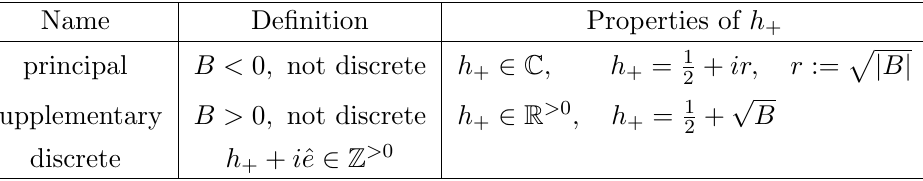
Table 2 . We categorize charged scalar (cid:12)elds in AdS 2 as principal, supplementary, or discrete depending on the values of the mass ^ (cid:22) and charge ^ e . We have de(cid:12)ned h + := 1 = 2 + B := 1 = 4 + ^ (cid:22) 2 (cid:0) ^ e 2 . This terminology originates in the representation theory of the near-horizon symmetry group SO(2 ; 1) [18, 19], although our de(cid:12)nition of discrete di(cid:11)ers when ^ e 6 = 0. The condition B > 0 is also called the Breitenlohner-Freedman (BF) bound [20{25]. Properties of h (cid:0) follow from the properties of h + using the relation h + + h (cid:0) =